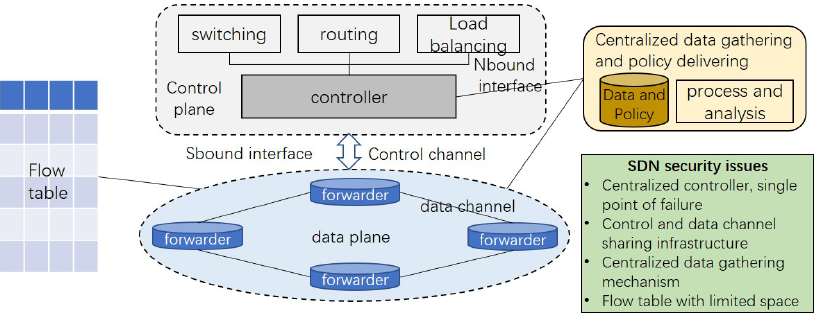
Figure 1. The security issues in SDN